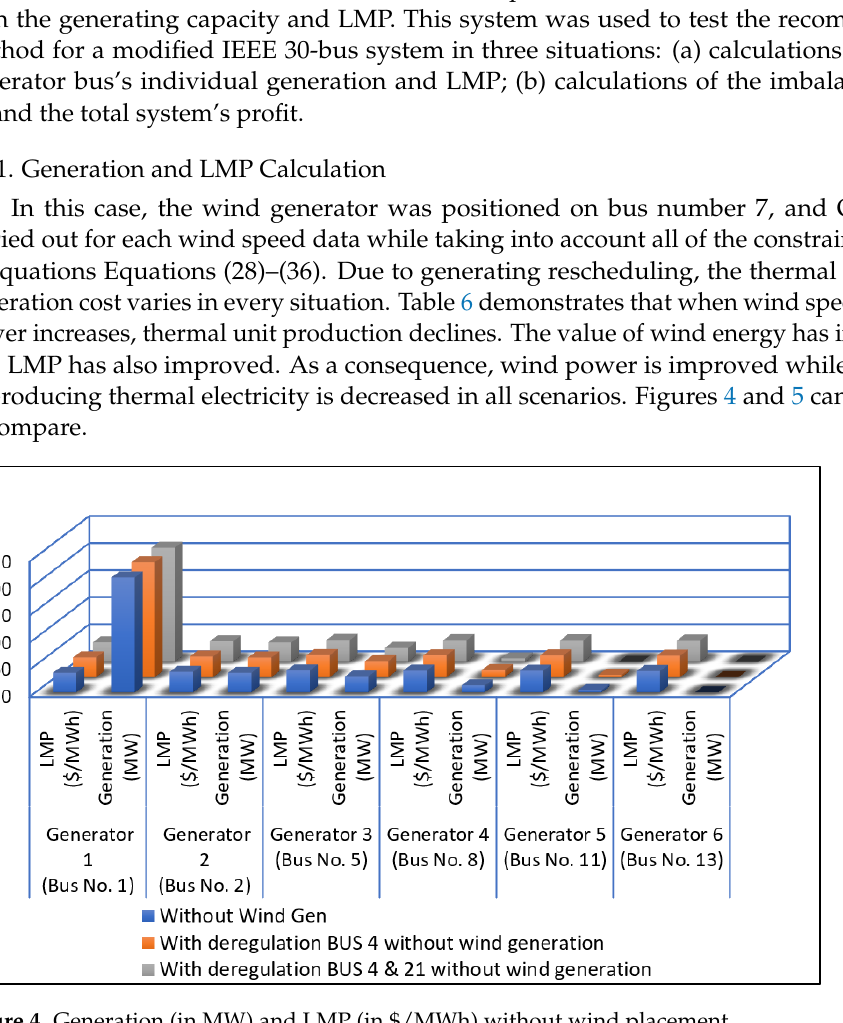
Figure 5. Generation (in MW) and LMP (in $/MWh) after wind placement. 5.1.2. Calculation of Imbalance Cost The imbalance cost was estimated using the Equations (20) to (23) for each variance in projected and real wind speeds. The system ’ s imbalance cost represents the difference between predicted and real wind speed data. The imbalance cost (negative) is highest when there is the largest discrepancy between the predicted and real wind speed. A deficit charge rate is obtained when the real wind speed is more than the predicted wind speed, and a surplus charge rate is obtained when the real wind speed is greater than the predicted wind speed. By taking the deficit and excess charge rates into account, we may estimate the total imbalance cost of the electrical system. The imbalance cost is zero if there is no difference between the predicted and real wind speed. Table 7 demonstrates that there is a certain number of hours in city cases where the cost of the imbalance is